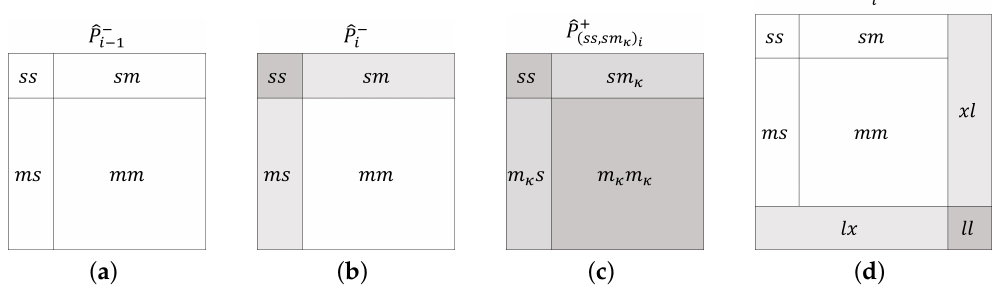
Figure 6. ( a ) Error covariance matrix at the beginning of the i th time step, ( b ) predicted covariance matrix, ( c ) updated part of the covariance matrix, and ( d ) augmented covariance matrix with a single new landmark. Shaded regions are where changes happen. Dark gray represents respective covariance and pale gray represents cross-variance.